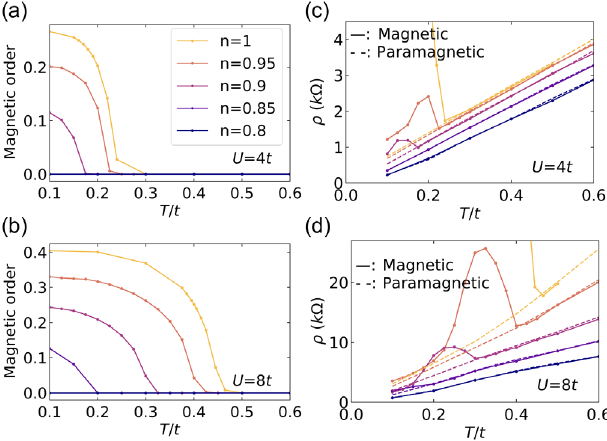
FIG. 6. (a),(b) Amplitude of the magnetic order [Eq. (7)] for U=t ¼ 4 , 8 and densities shown, at ϕ ¼ π = 6 . (c),(d) Solid line: resistivity computed at densities shown for U=t ¼ 4 , 8, including the effects of magnetic order; dashed line: resistivity, computed in the paramagnetic state.